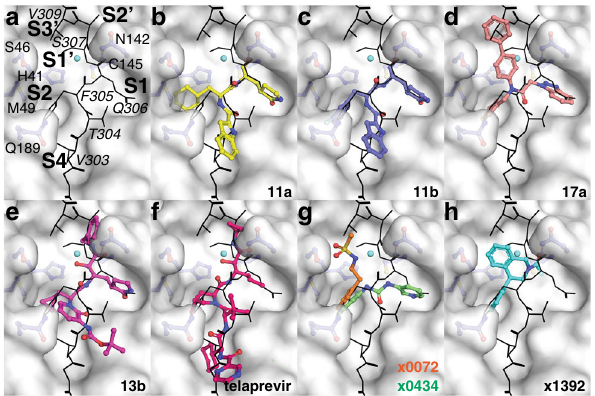
Fig. 5 M pro inhibitor binding in relation to the enzyme – substrate complex model. The surface in each panel is that of chain B of the acyl-enzyme structure. The C-terminal autocleavage site enzyme – substrate complex model for SARS-CoV-2 (see Fig. 4b) is shown in black lines. The protomer B active site binding pockets (S1, S2, S4, S2 ′ , and S3 ′ ) and bound B ′ substrate residues (italics) are labeled in panel a. b – h Superposed drugs are shown in colored cpk representation with published names provided for each. PDB accession codes: 11a — 6LZE, 11b — 6M0K, 13b — 6Y2G, telaprevir — 7C7P, x0072 — 5R7Y, x0434 — 5R83, and x1392 — 5RFT. Drawings for each inhibitor can be found in Supplementary Fig. 8.